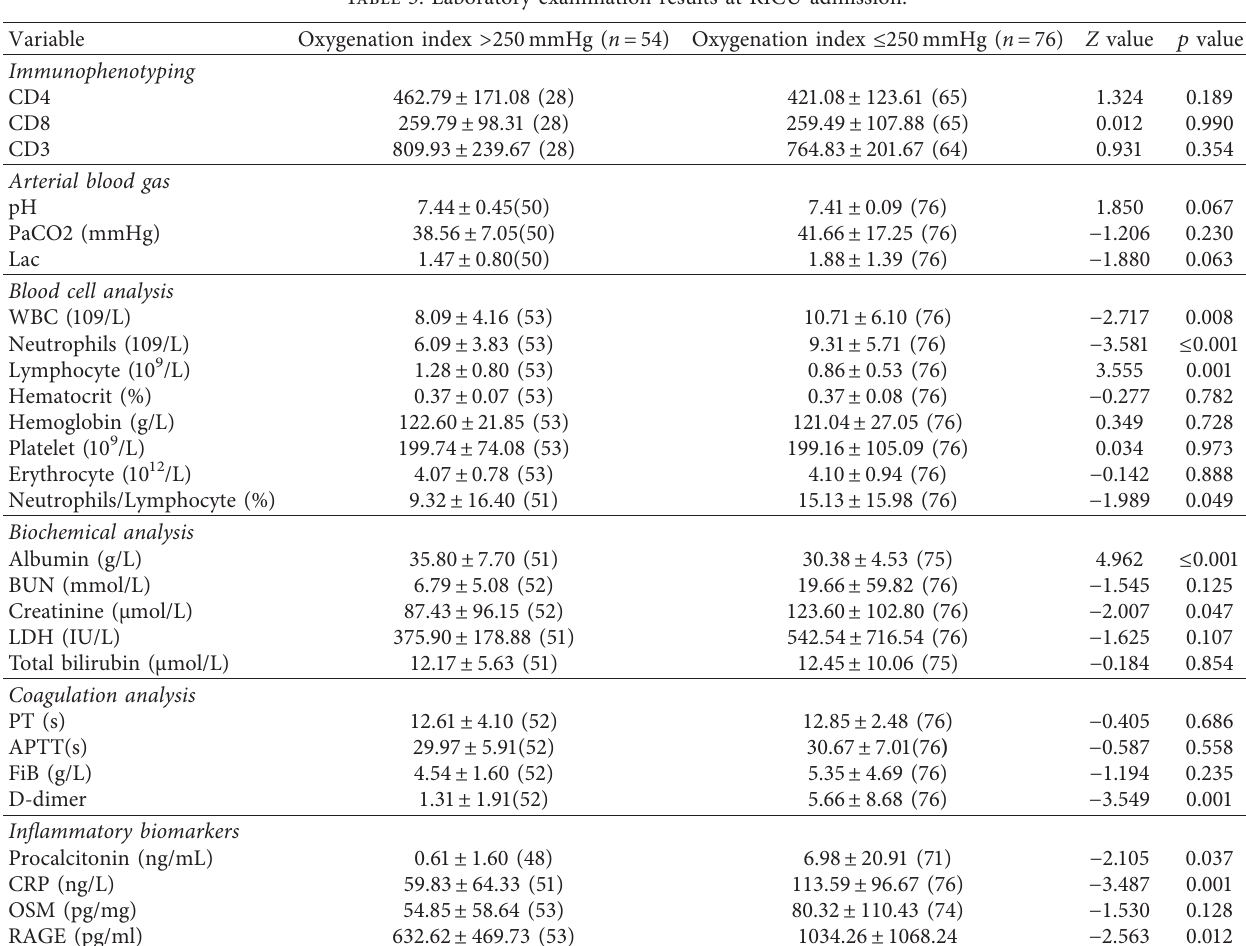
Table 3: Laboratory examination results at RICU